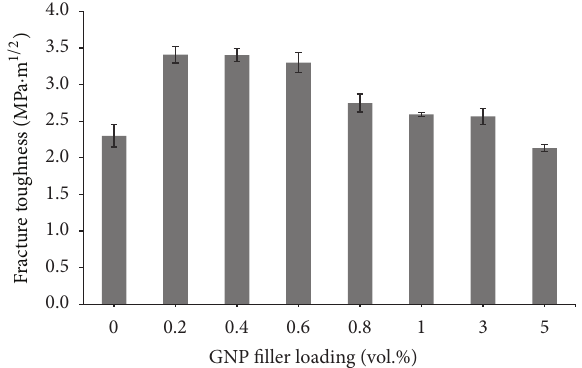
Figure 2: Flexural strength of GNP filled epoxy composites.